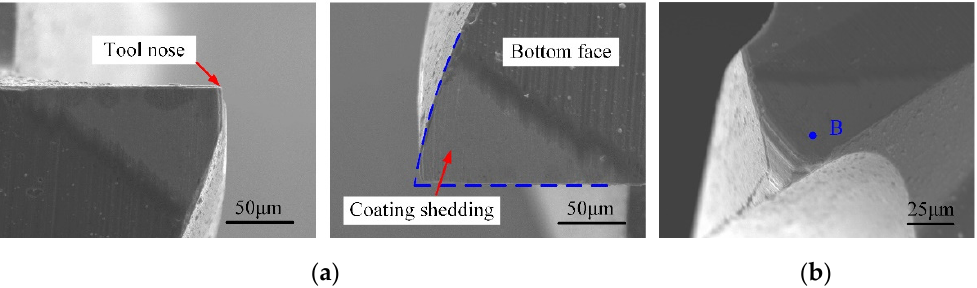
Figure 16. Tool wear of two-fluted carbide micromilling cutter. ( a ) Top view of bottom surface; ( b ) Tool nose area.